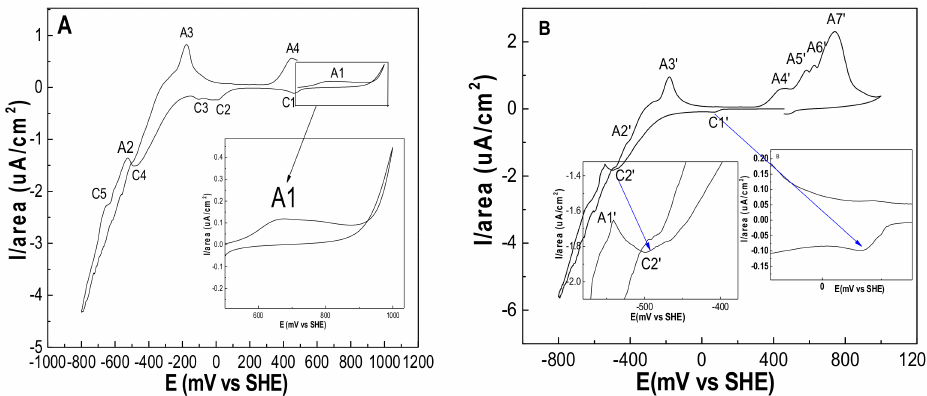
Figure 1. The ( A ) forward cyclic voltammetry (CV) and ( B ) reverse CV of chalcopyrite at the scan rate of 5 mV s − 1 in 9 K medium at pH 1.8. SHE: standard hydrogen electrode.